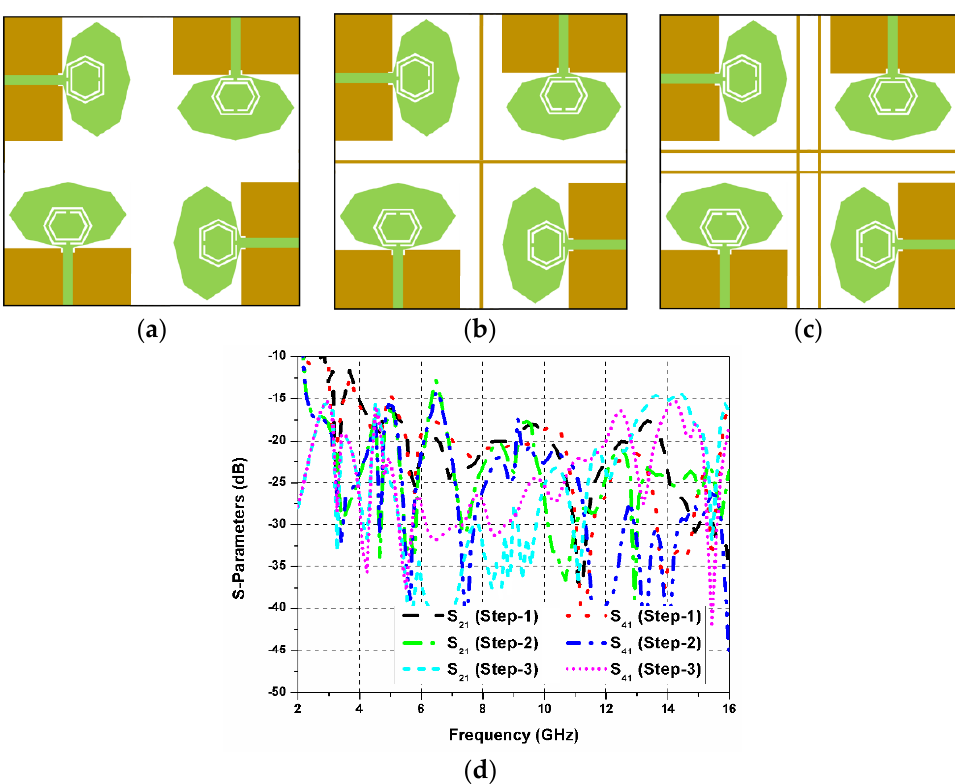
Figure 6. Proposed UWB MIMO antenna design steps: ( a ) step-1; ( b ) step-2; ( c ) step-3; ( d ) mutual coupling comparison.